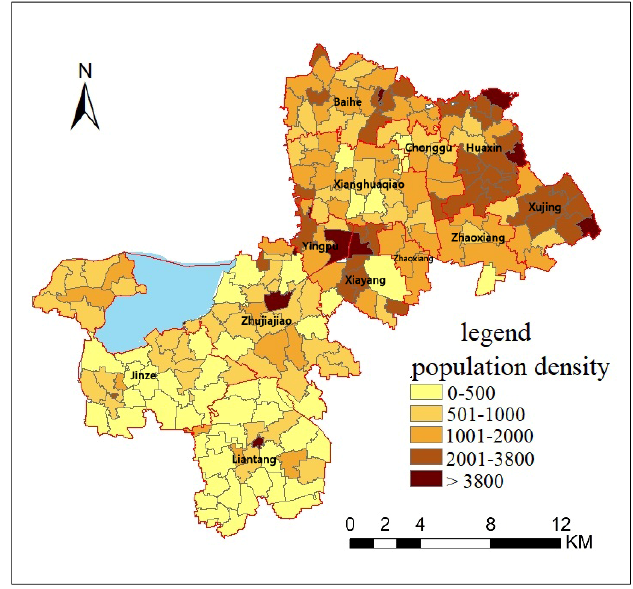
Figure 2. Population density of 203 evaluation units in Figure 2 . Population density of 203 evaluation units in Qingpu.